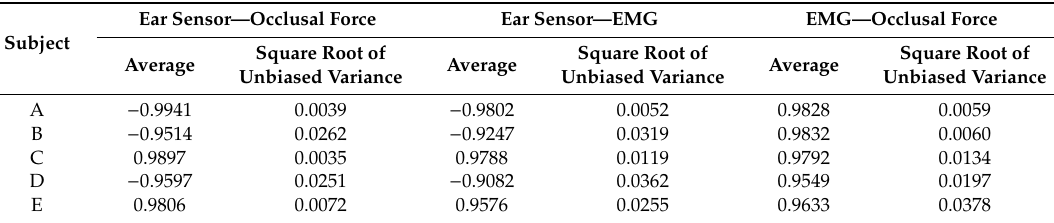
Table 1. Results for correlation coe ffi cients. Average and square root values of unbiased variance from correlation coe ffi cients between ear sensor value and occlusal force, ear sensor value and electromyography (EMG) value, and EMG value and occlusal force, as obtained over six runs for subjects A through E using the experimental method of Section 2.4 are given.